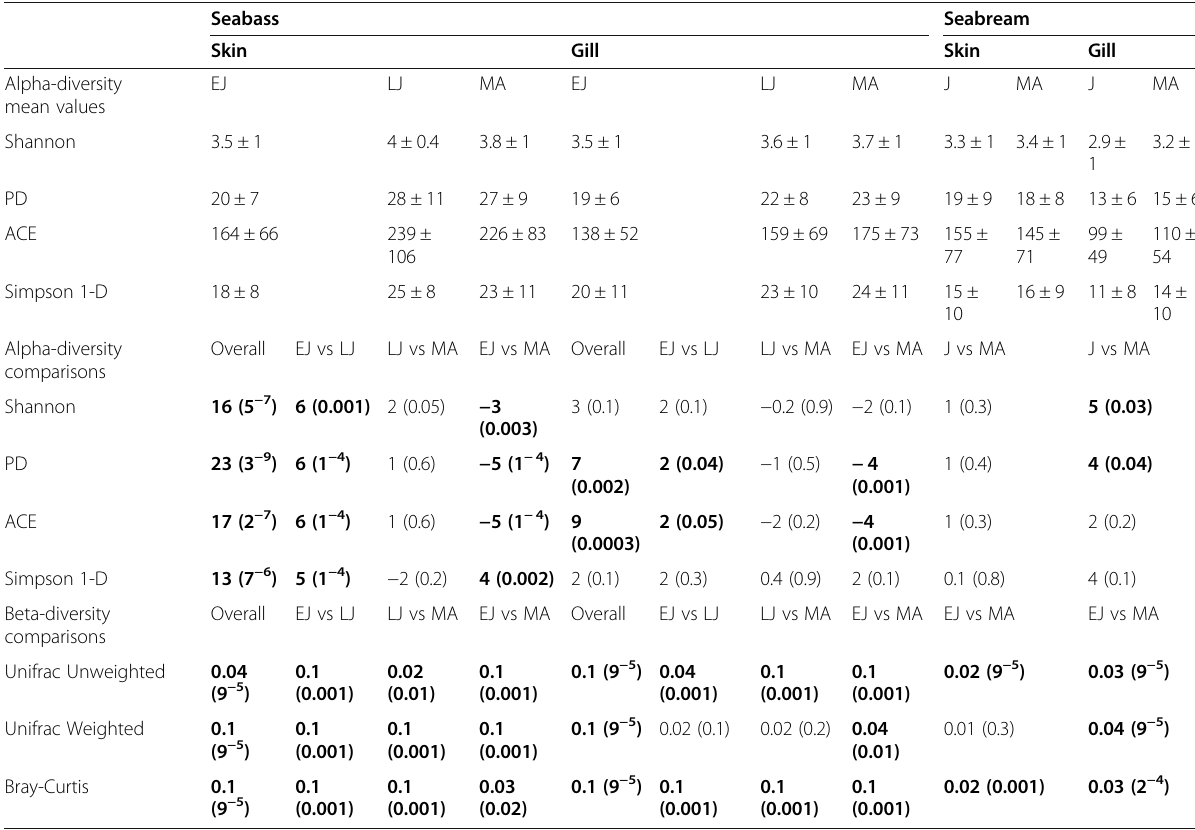
Table 1 Mean alpha-diversity values, and alpha- and beta-diversity comparisons for the skin and gill microbiota of the different age groups of seabass Dicentrarchus labrax and seabream Sparus aurata ( n = 60 per species x age group x